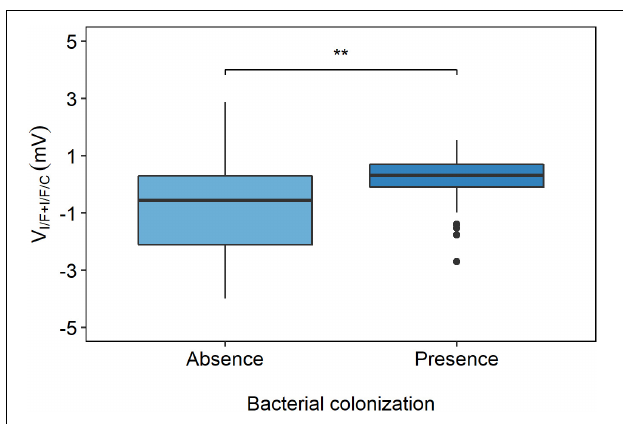
FIGURE 7 | Distribution of V I / F + I / F / C values in individuals with and without bacterial colonization. The V I / F + I / F / C values were plotted and grouped by the absence or presence of bacterial colonization, and show that less bacterial colonization occurs in PwCF with lower V I / F + I / F / C values and that higher frequency of bacterial colonization occurs in PwCF with higher V I / F + I / F / C values, [Kruskal–Wallis rank sum test (** p ≤